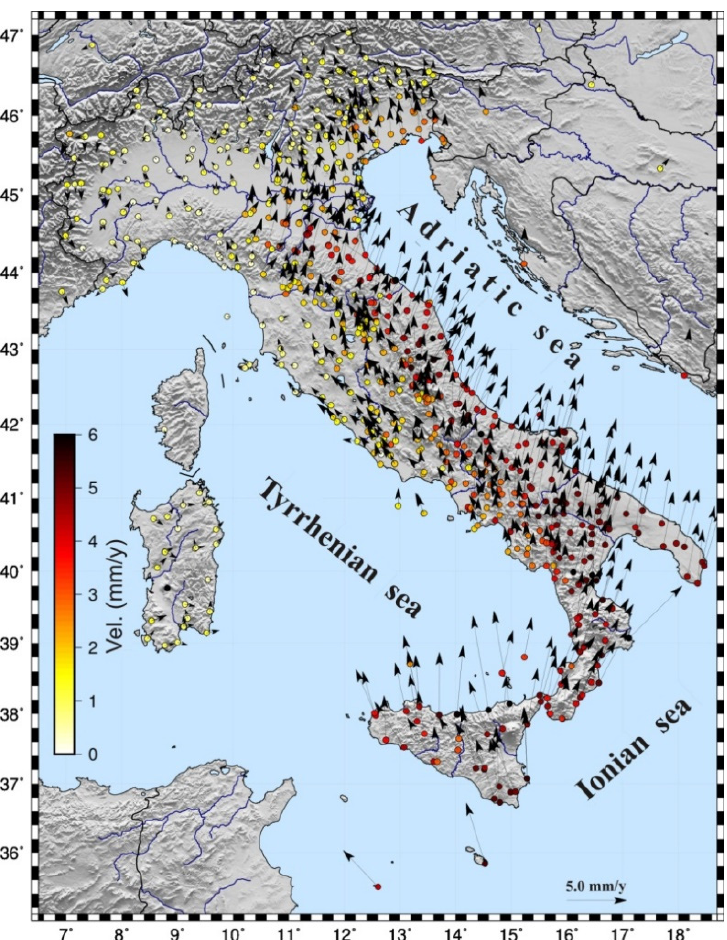
Figure 14. Horizontal velocity field in the Italian peninsula, derived by GPS data, with respect to a fixed Eurasian plate in the ITRF2014 reference frame [237]. The colours of station sites indicate velocity following the chromatic scale on the left. The description of the GPS network and data analysis is given by